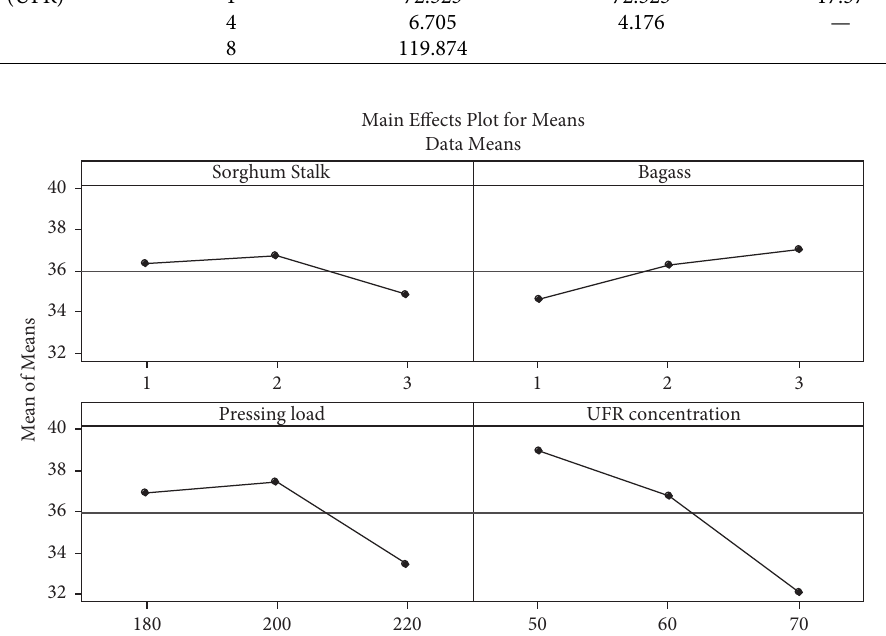
Figure 11: Main effects plot for means of thickness